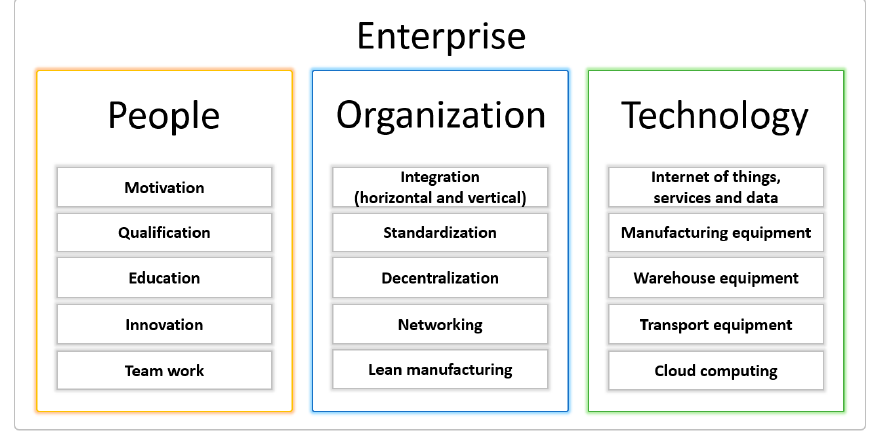
Figure 4. The key enablers to move towards new paradigms: people, organization, and technol- ogy.